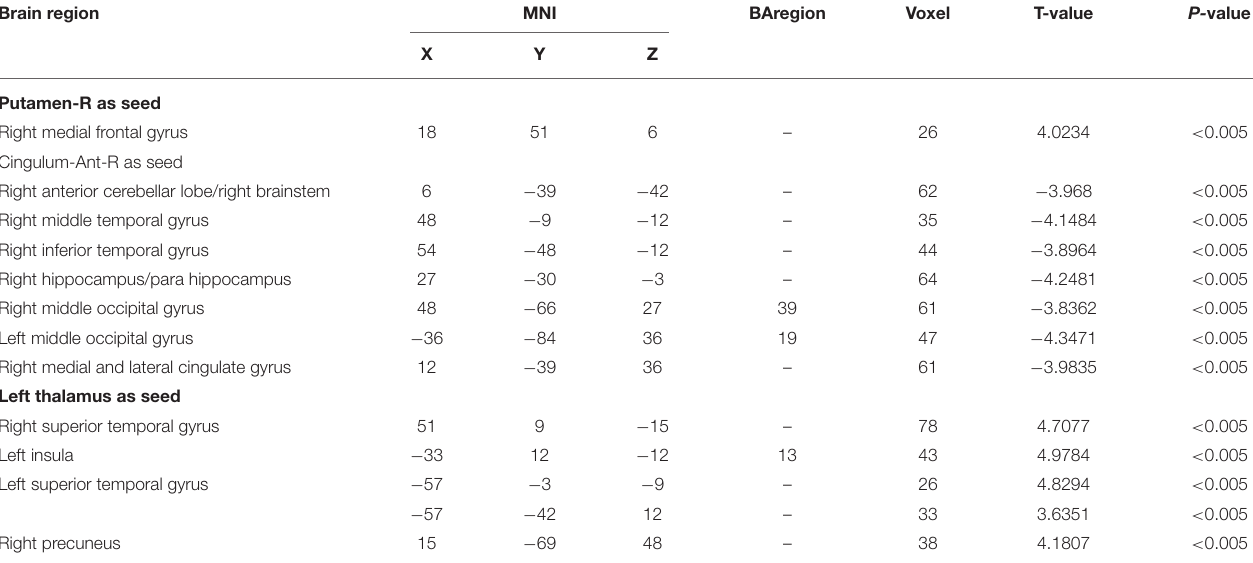
TABLE 3 | Comparison of FC data. Brain